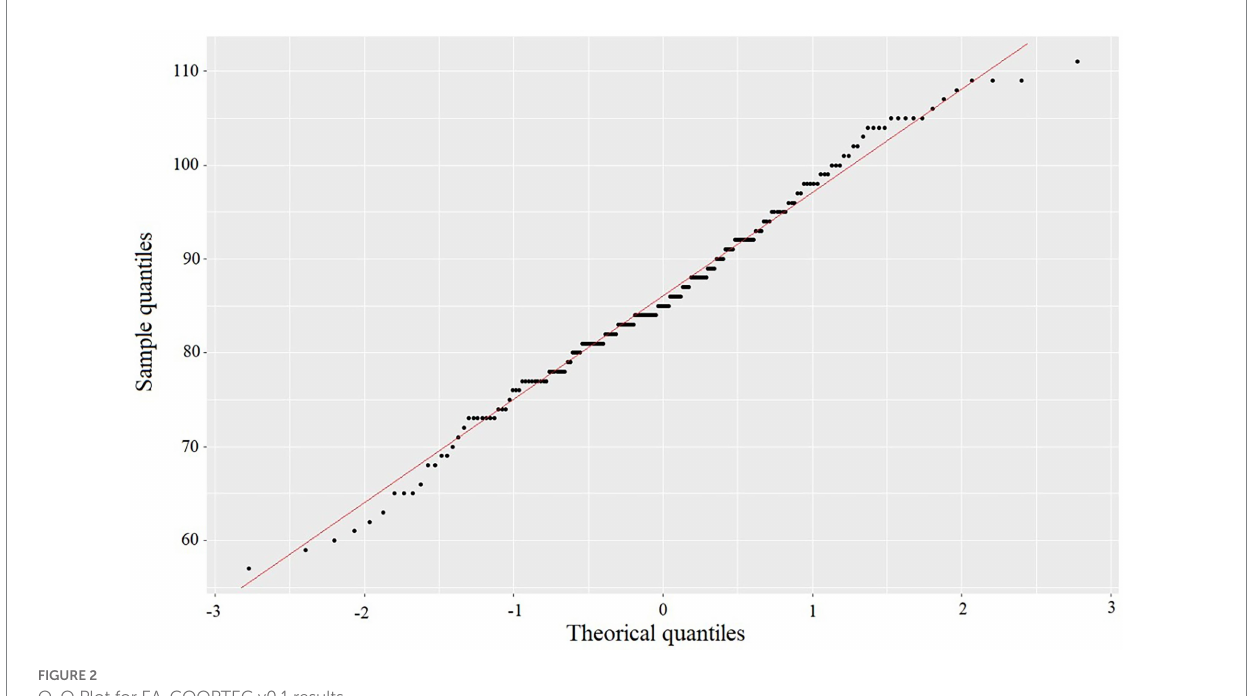
FIGURE 2 Q-Q Plot for EA-COOPTEC v0.1 results.